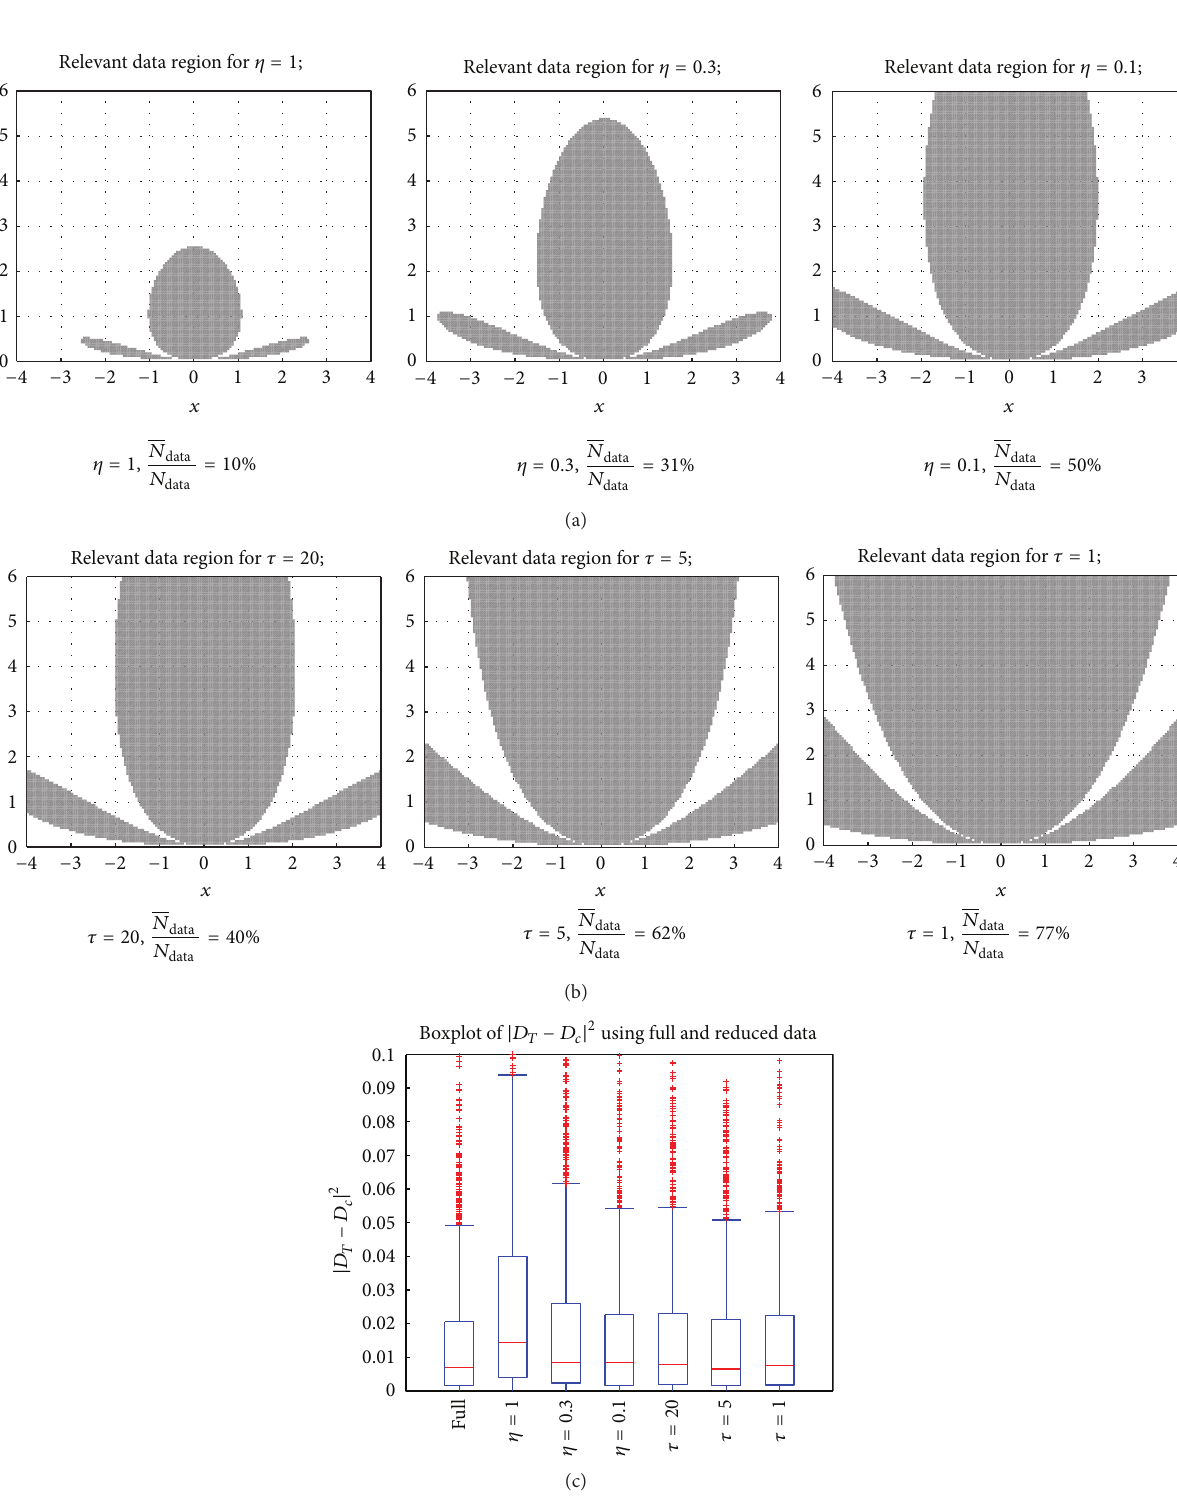
= 0 . 1, and additive 0